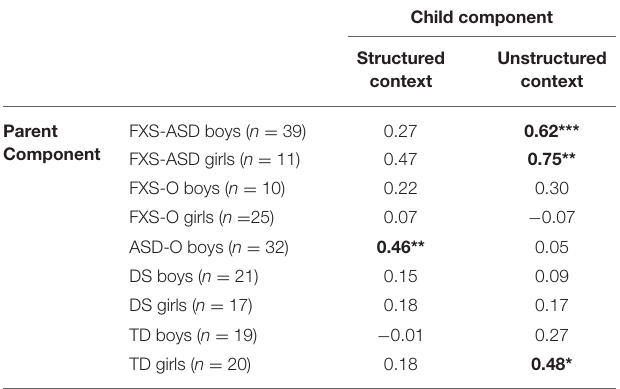
TABLE 5 | Interrelationships between parent and child pragmatic language.